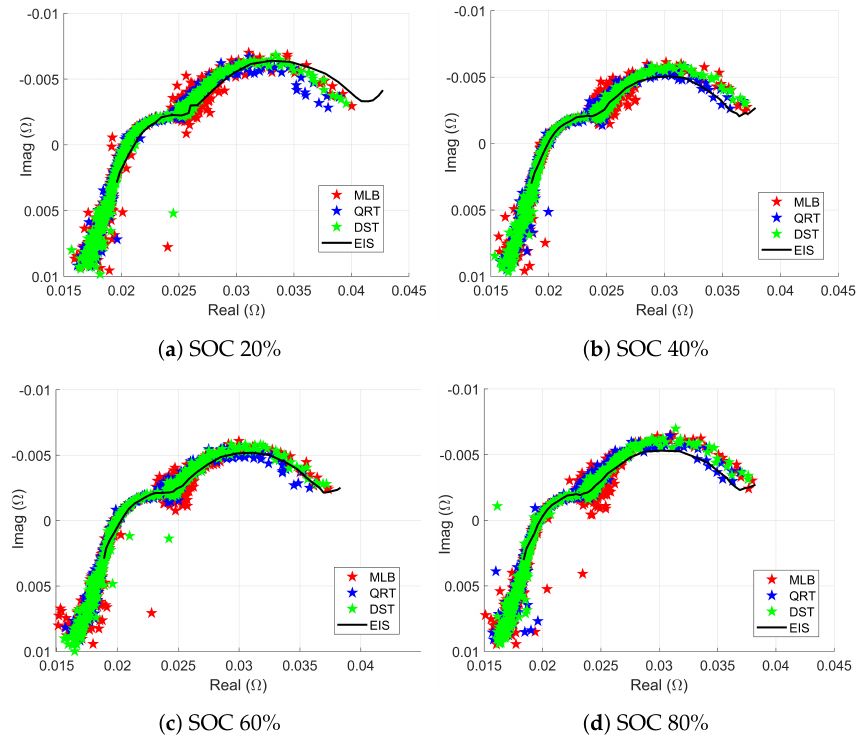
Figure 5. Sub-band impedance measurements in the complex-plane at different